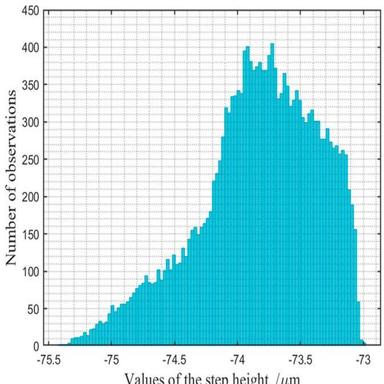
The distribution of the heights of subtracting the datum plane from the plane SB in Experiment 1.